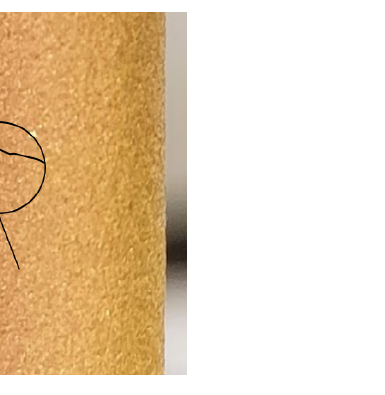
Figure 7. The appearance of fatigue cracks during fatigue loading.